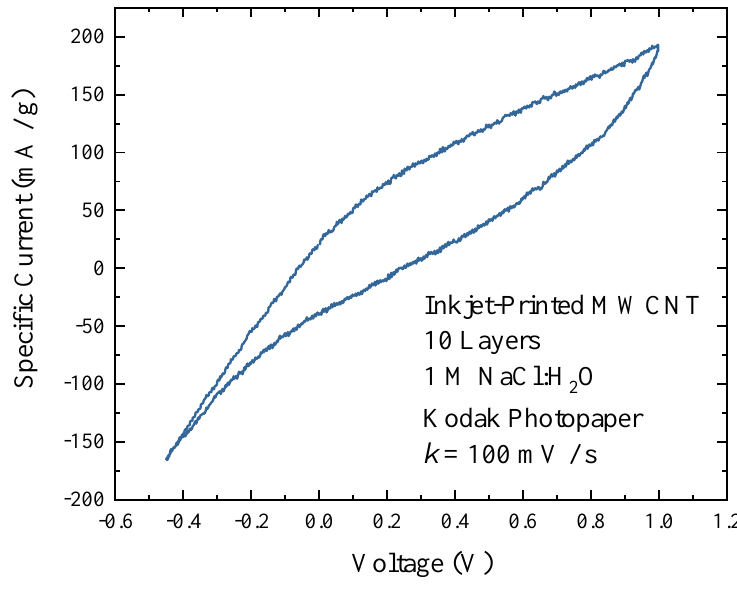
Figure 23. Cyclic voltammetry of the capacitive device built with inkjet-printed MWCNTs.